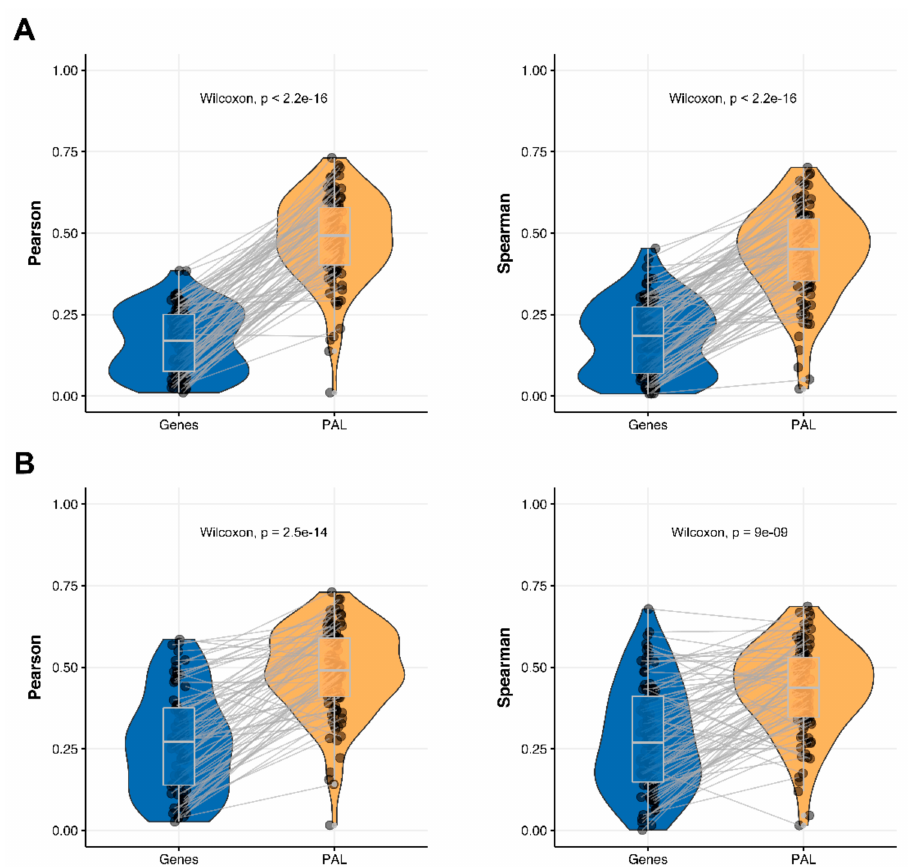
Figure 4. Paired gene-to-gene and PAL-to-PAL correlation between RNA and protein expression levels estimated within Breast Invasive Carcinoma biosamples using Pearson ( left ) and Spearman ( right ) correlation coefficients for ( A ) the total set of genes and molecular pathways; ( B ) the set of drug target genes and molecular pathways